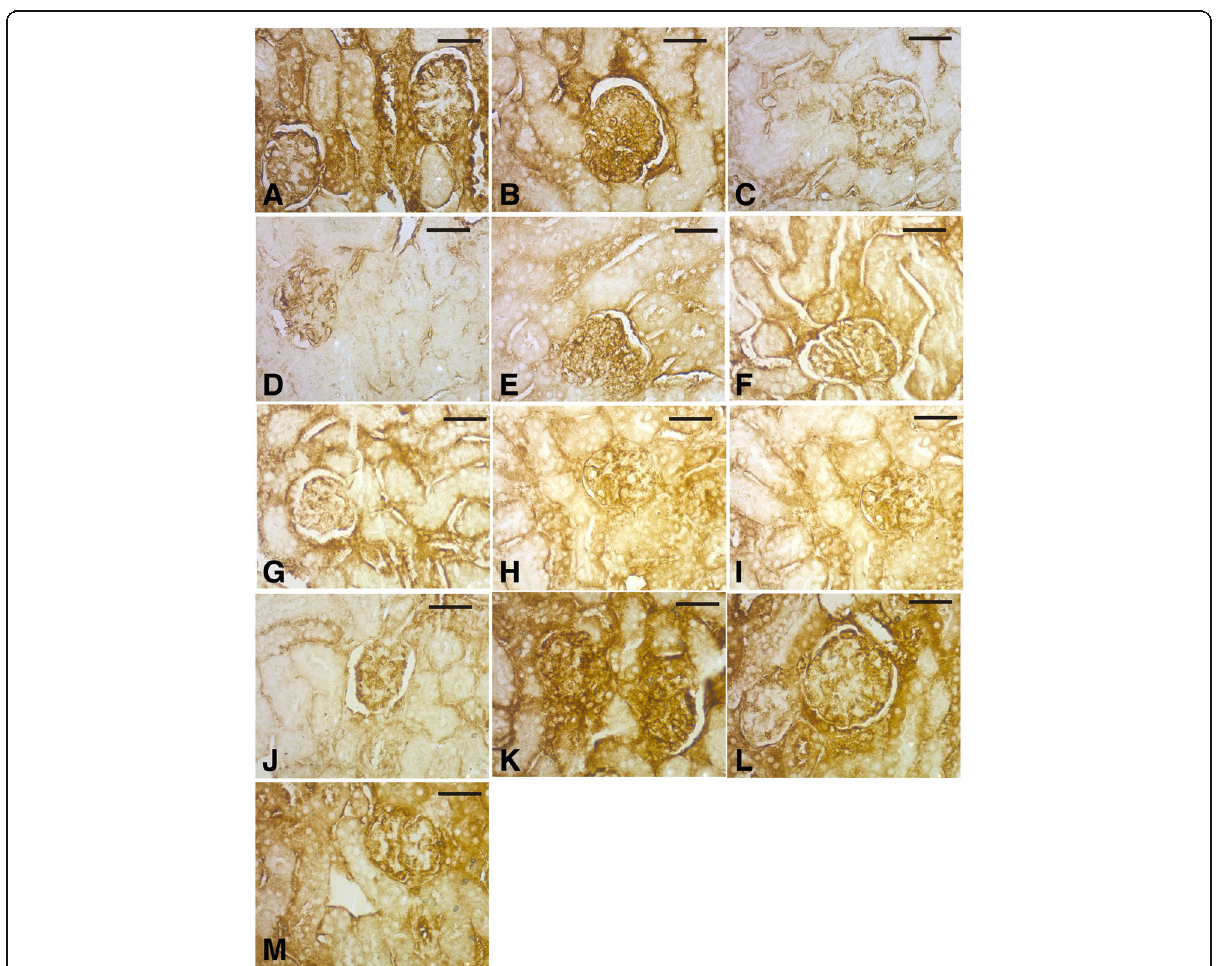
Fig. 6 Photomicrographs of immunohistochemistry of cytochrome C in kidney sections of the control group ( a ). Acrylamide-administrated groups showed the decrease in expression at 30, 45, and 60 days ( b – d ). Chips feeding groups at 30, 45, and 60 days ( e – g ) showed slight downregulated expression compared to the control. BV-treated group ( h ) and BPF-treated group ( i ) at 60 days showed downregulated expression of cytochrome C as compared to the control. Acrylamide-administrated groups treated with either BV ( j ) or BPF ( k ) showing improvement of downregulated expression of cytochrome C compared to acrylamide administration. Chips feeding groups treated with either BV ( l ) or BPF ( m ) showing the normal expression and distribution of staining that was mostly similar to the control. Immunostaining of cytochrome C scale bar 10 μ